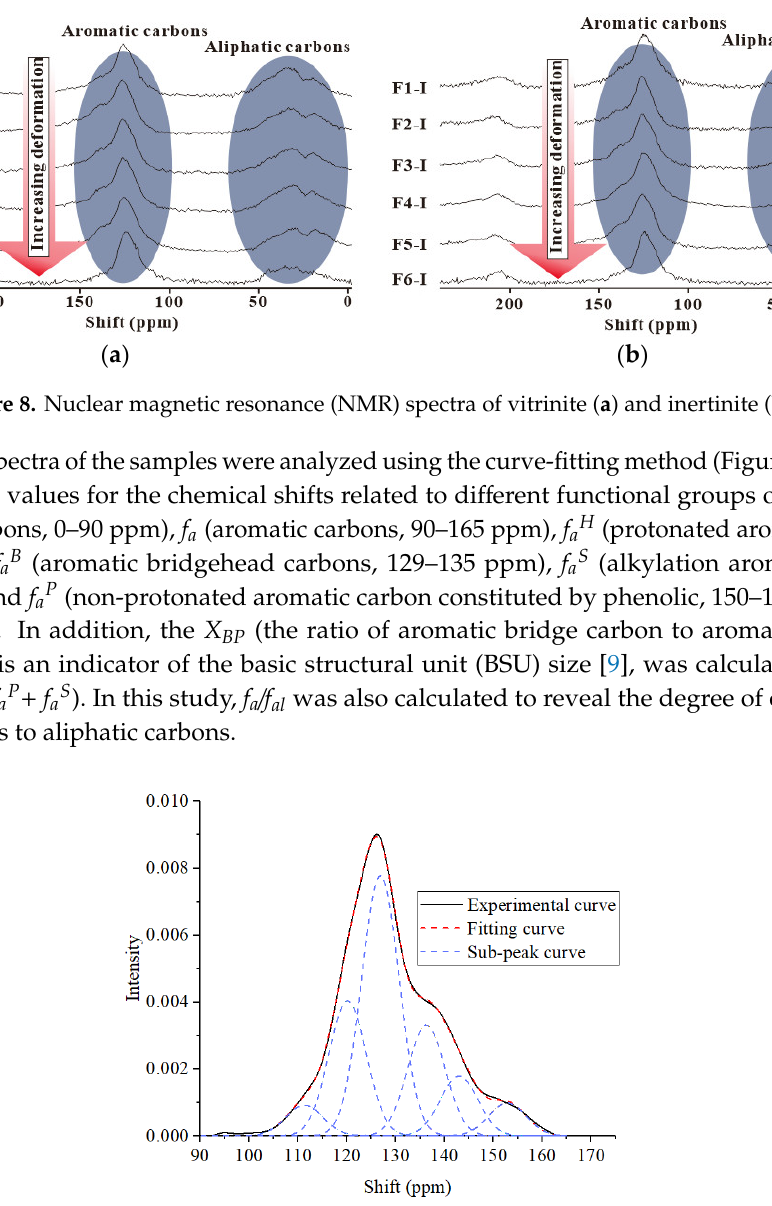
Figure 9. Curve-fitting method (Taking Sample F1-V as an example).